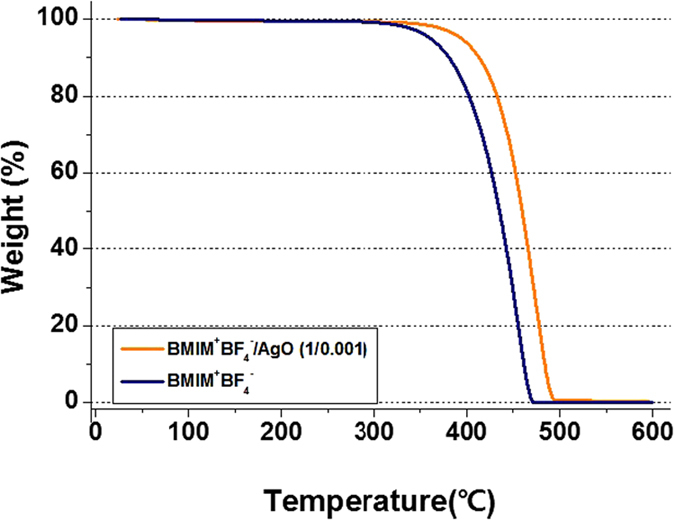
TGA curves of BMIM+BF4− and BMIM+BF4−/AgO.